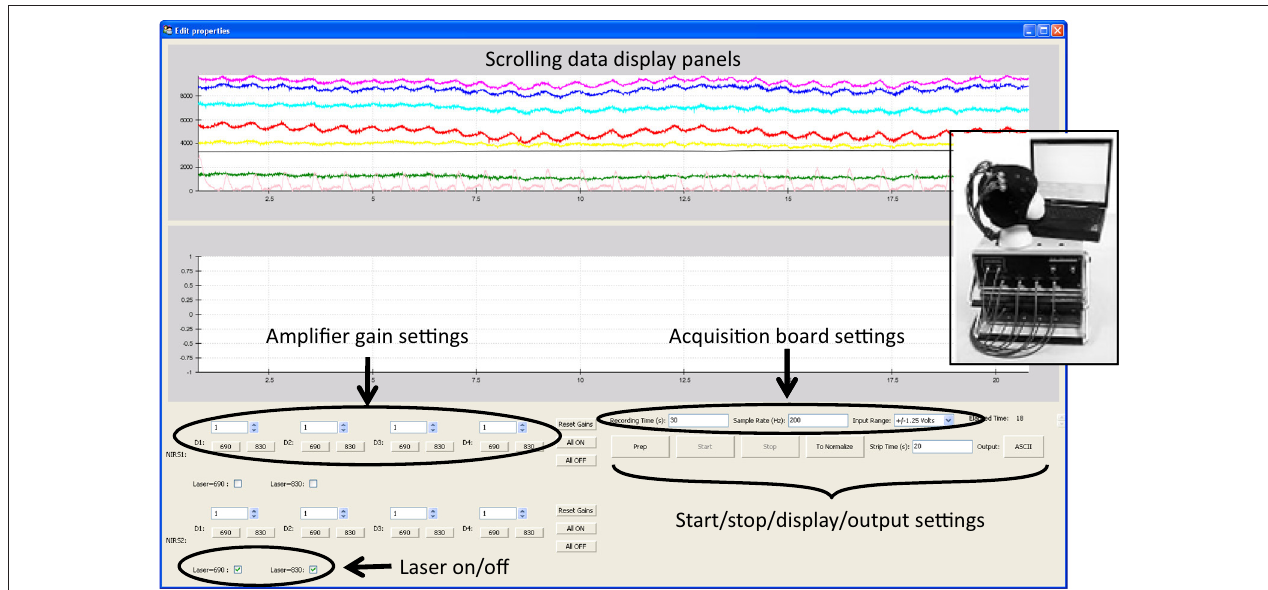
FIGURE 2 | Screenshot from the NinDAQ device control and data acquisition program. Inset: The NIN recording devices and head probe being controlled by this